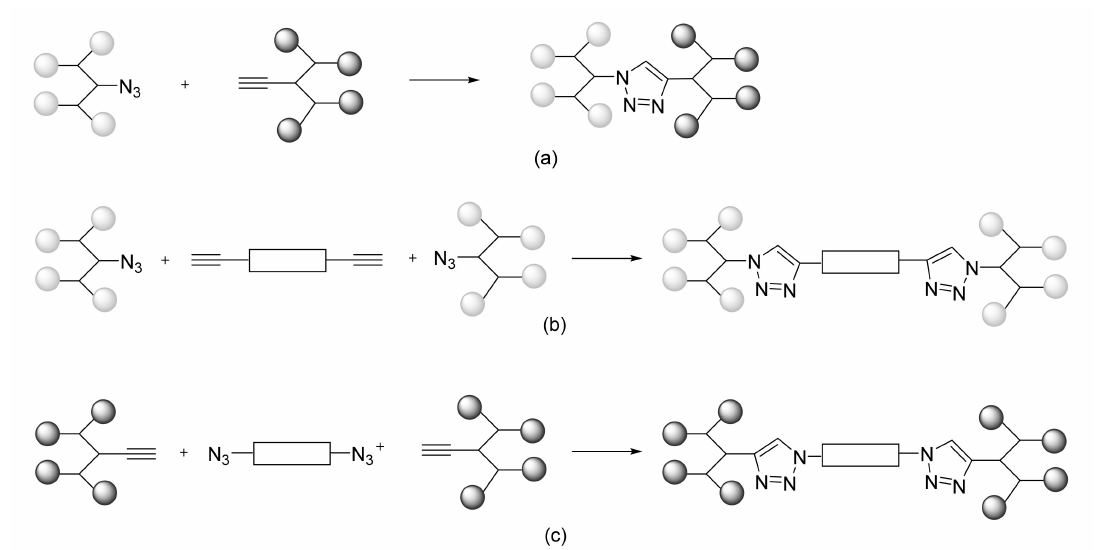
Figure 23. Strategy for the synthesis of peptide dendrimers using click chemistry. ( a ): CuAAC of an alkyne anchored in one dendron and an azide in another dendron; ( b ): CuAAC of a dialkyne nucleus and dendrons functionalized with azide units; ( c ): CuAAC of a diazide nucleus and dendrons functionalized with alkyne